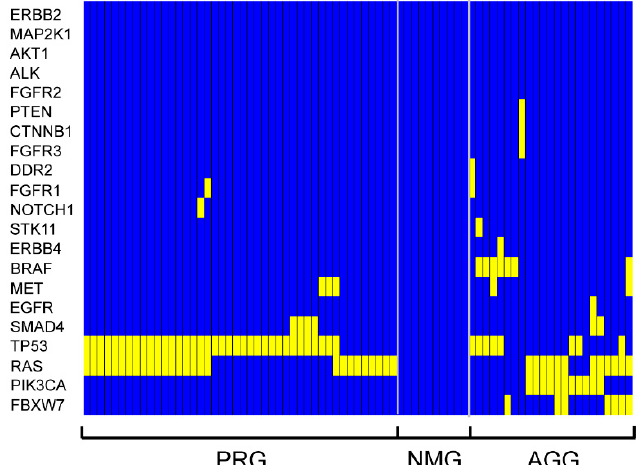
Figure 2. Heat-map representation of hierarchical clustering analysis of mCRC data. Columns represent the 77 samples of mCRC patients and rows represent the 22 different mutational markers. Three separate clusters were generated by this analysis. Each cluster corresponds to a distinct genetic profile. The color assigned to a cell in the heatmap grid indicates mutational condition (yellow for mutation, blue for wild-type gene) of a particular gene in a given patient sample.